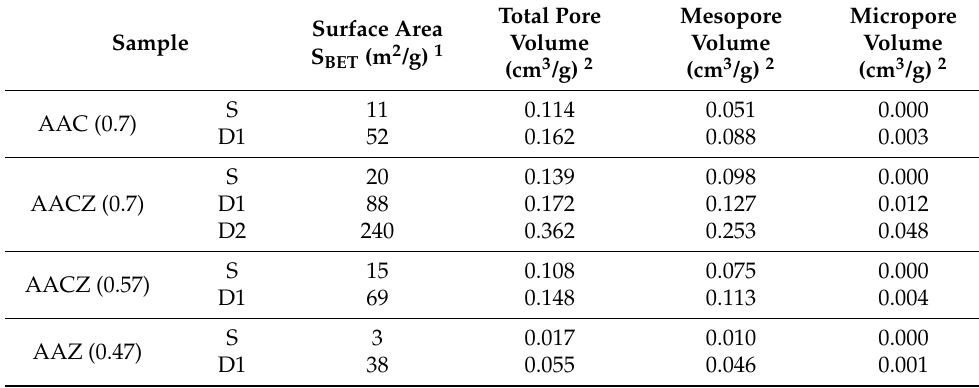
Table 4. Surface area S BET and pore volumes of samples.